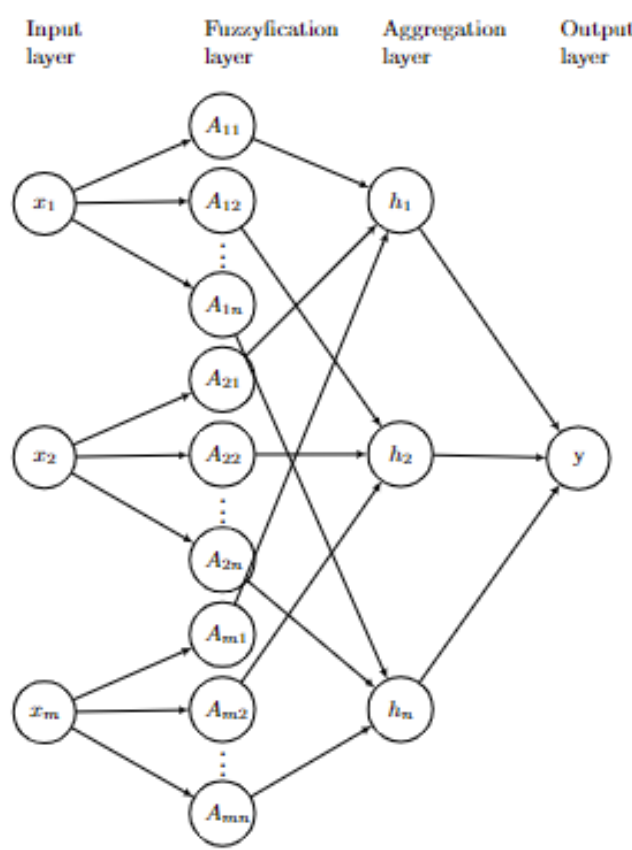
Figure 2. Example of a layered fuzzy neural